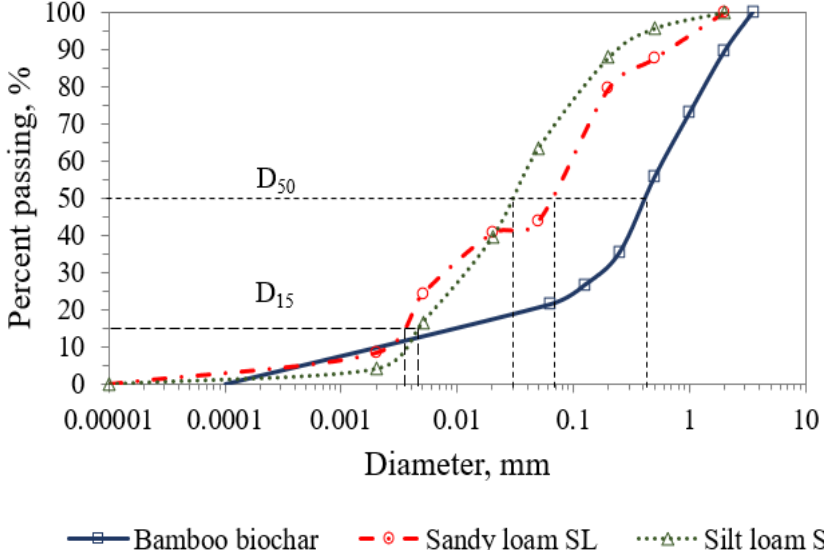
Figure 3. Particle size distribution of the bamboo biochar (squares and continuous blue line), and the soil materials: sandy loam (circles with dashed red line) and silt loam (triangles with dotted green line).